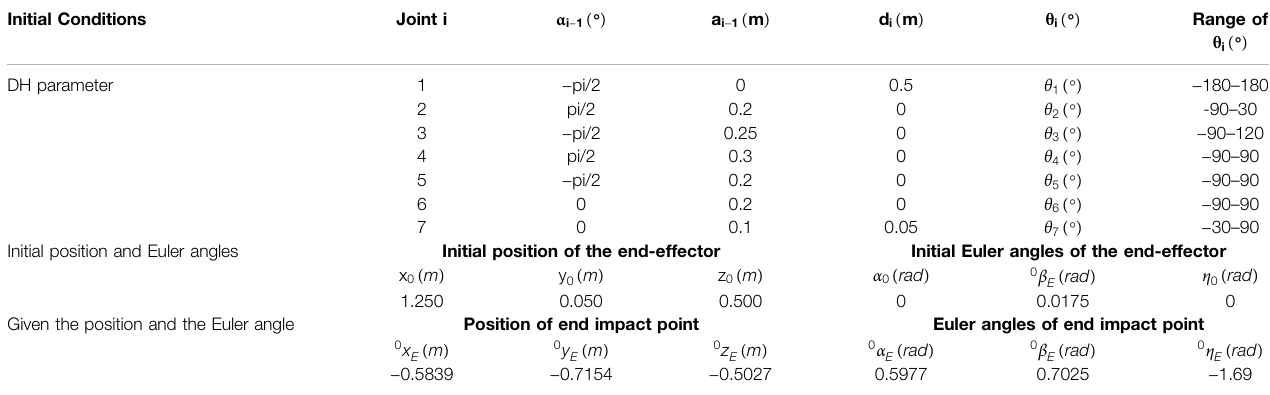
TABLE 9 | Initial condition setting of Seven degrees of freedom robot arm.